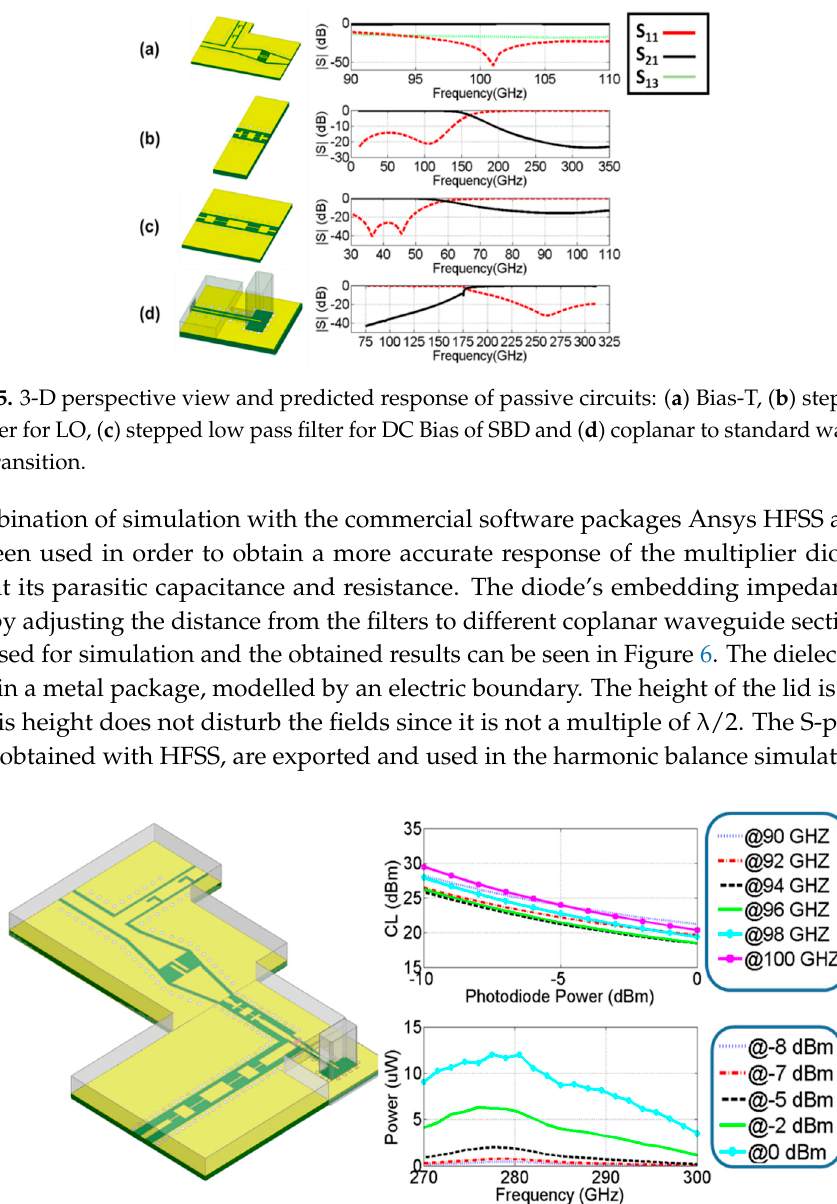
Figure 5. 3-D perspective view and predicted response of passive circuits: ( a ) Bias-T, ( b ) stepped low pass filter for LO, ( c ) stepped low pass filter for DC Bias of SBD and ( d ) coplanar to standard waveguide WR-3 transition.